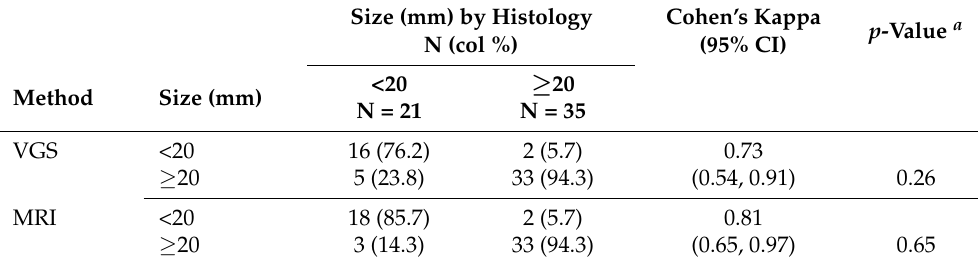
Table 3. Methods comparison with the gold standard by tumor size (maximum diameter, mm).